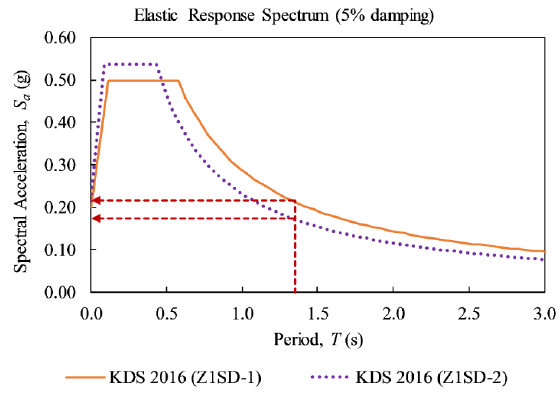
Figure 3. A comparison of the structural response using elastic response spectra of Korean Design Standard (KDS). Standard